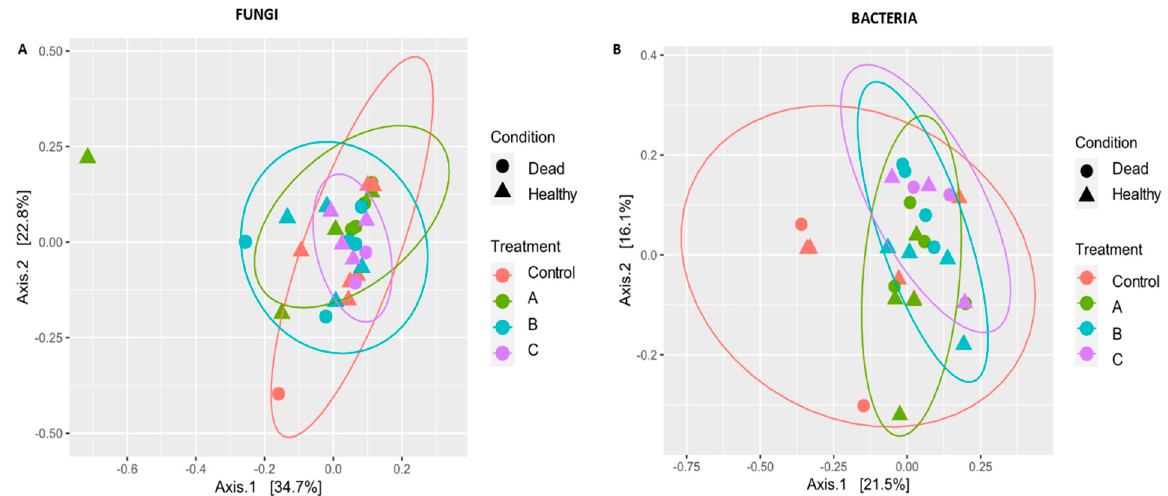
Figure 2. Beta diversity . The graphic shows the differences and the similarities between the samples due to the treatment and the condition: ( A ) PCoA (Principal Coordinates Analysis) for fungi; ( B ) PCoA for bacteria.